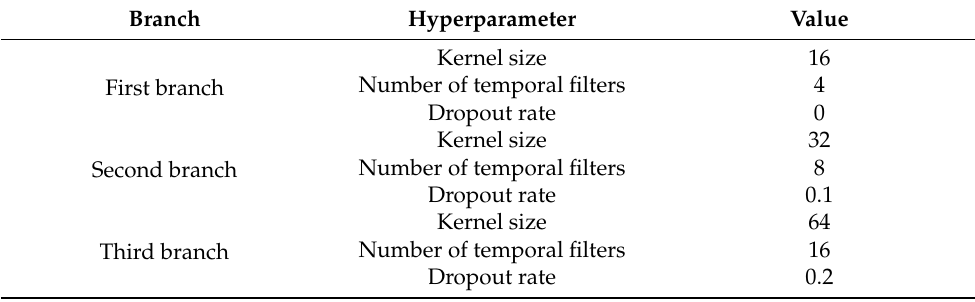
Table 2. Global hyper-parameters used for all subjects in MBEEGNet.